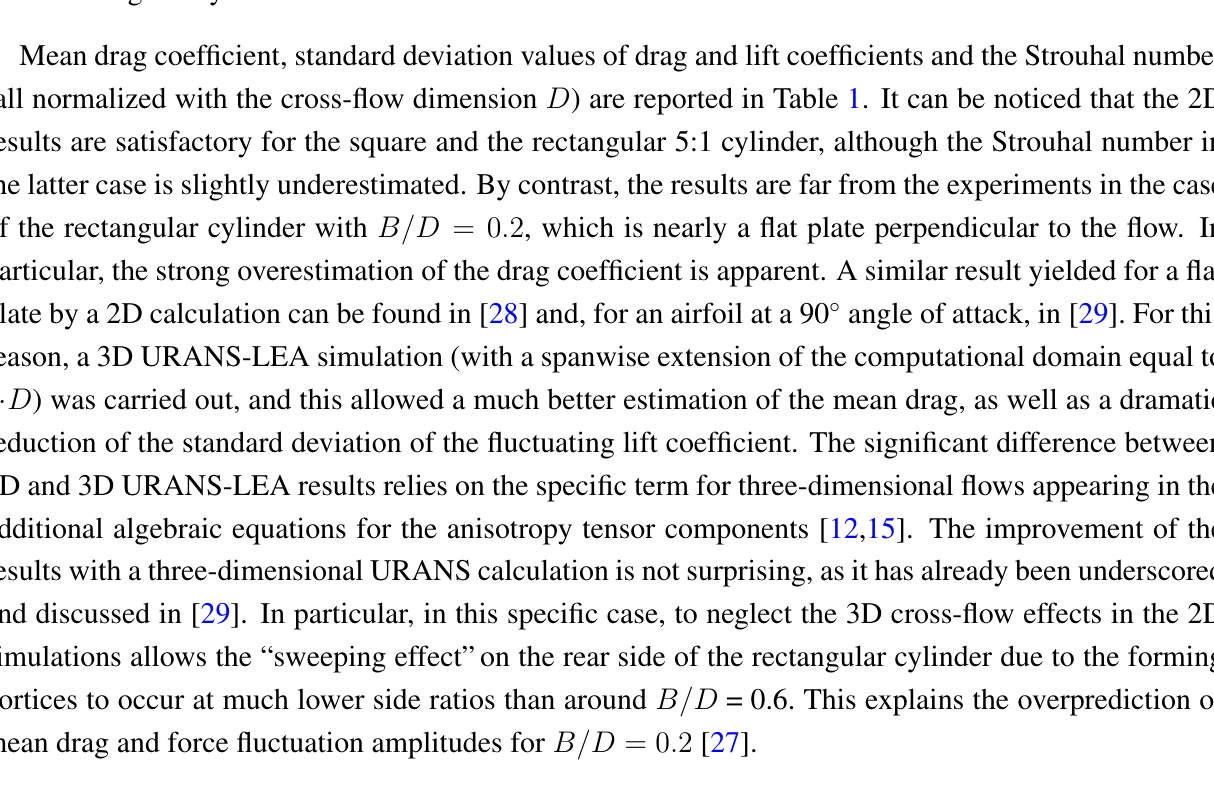
Figure 1. Near-body views of the computational grids used for the simulations of flow past rectangular cylinders of various side